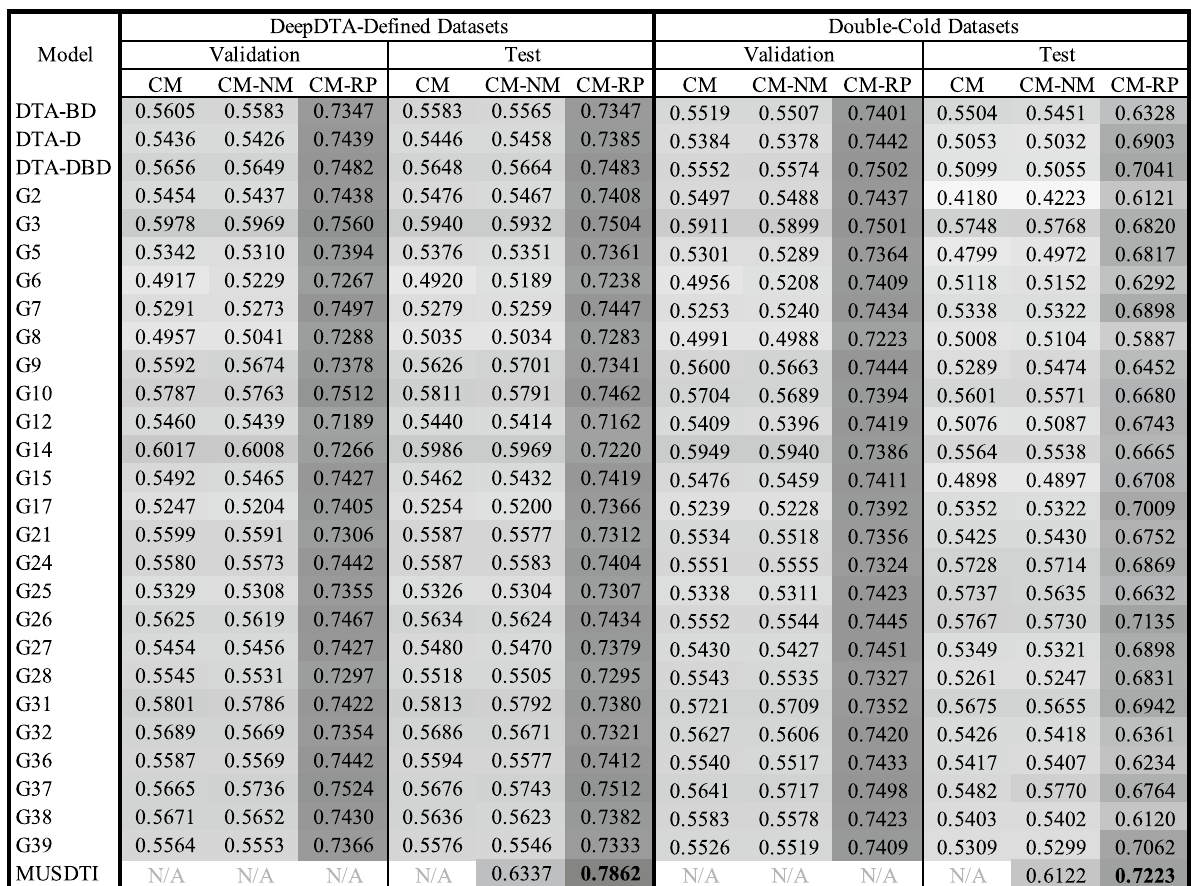
Table 4. Component and MUSDTI model performance evaluated over the validation and test datasets using concordance